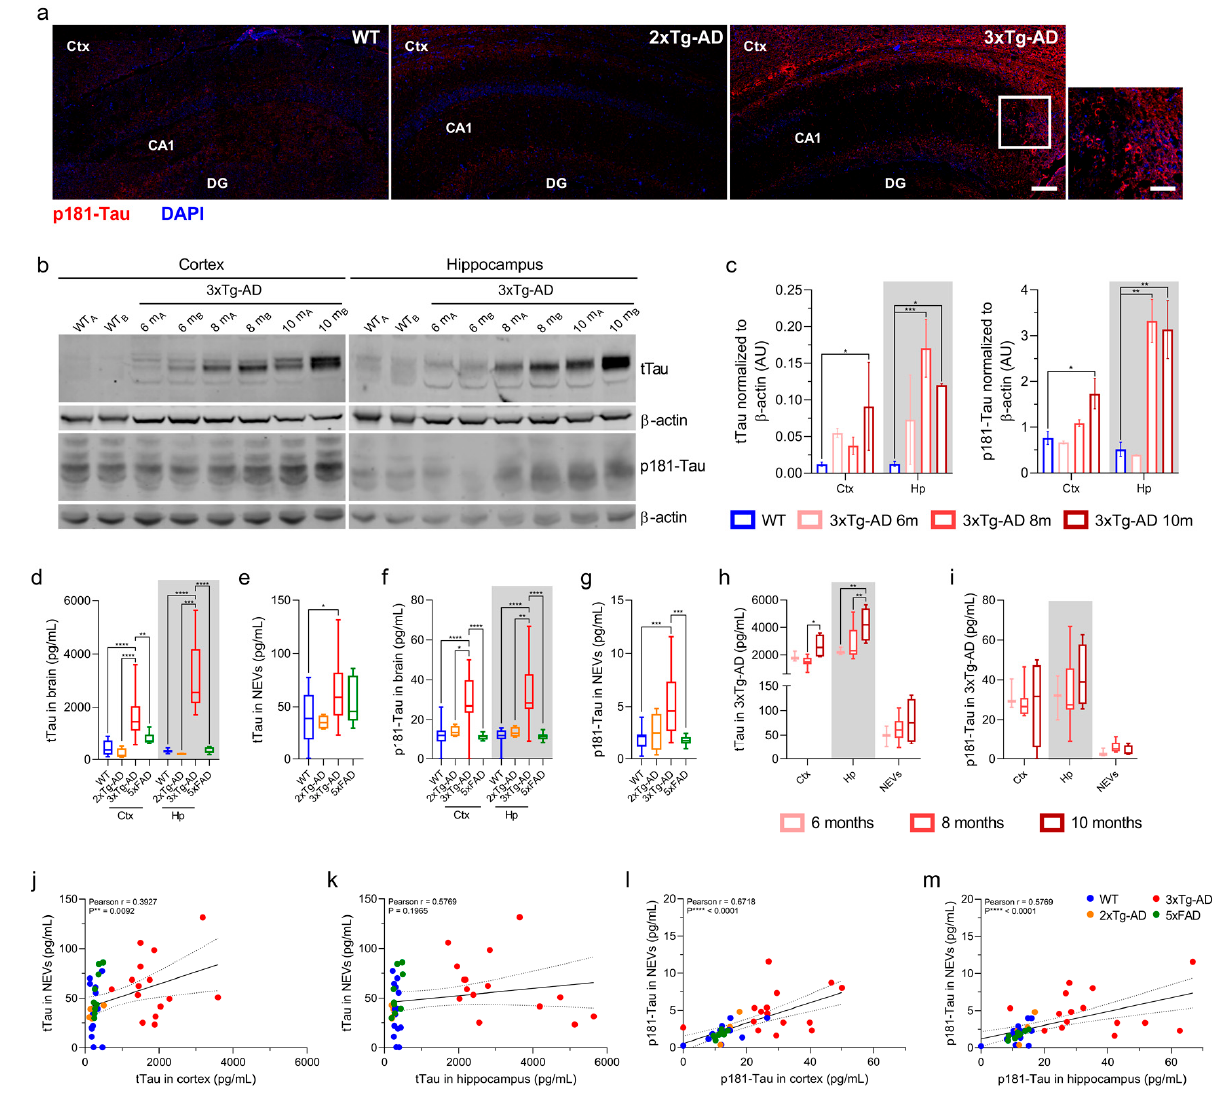
Figure 2. tTau and p181 ‐ Tau in NEVs are positively correlated with brain levels. ( a ) p181 ‐ Tau fluorescence immunohisto ‐ chemistry (red), with DAPI ‐ stained nuclei (blue), of the Ctx and Hp of a 10.5 ‐ month ‐ old 3xTg ‐ AD mouse compared to WT (5.7 months) and 2xTg ‐ AD (8.3 months) negative controls (20 X , scale bar, 200 μ m). Square inset in 3xTg ‐ AD image: scale bar, 100 μ m. ( b ) tTau (HT7) and p181 ‐ Tau (AT270) WB, resolved in individual membranes, showing brain levels of two 3xTg ‐ AD mice per age group compared to WT (6 ‐ month ‐ old). ( c ) WB quantification of tTau and p181 ‐ Tau normalized to β‐ actin (one ‐ way ANOVA; tTau in Ctx: * p = 0.0103, 10 months; tTau in Hp: *** p = 0.0002, 8 months, and * p = 0.0381, 10 months; p181 ‐ Tau in Ctx: * p = 0.0214, 10 months; p181 ‐ Tau in Hp: ** p = 0.0077, 8 months, and ** p = 0.0099, 10 months). Mice used for tTau assessment: WT, n = 6, age mean = 5.3 months; 3xTg ‐ AD, two of which are 6 ‐ months, six of which are 8 ‐ months and two of which are 10 ‐ months old (as indicated by age ‐ specific colored dots). Mice used for the p181 ‐ Tau assessment: n = 2 for all groups. ( d – g ) Box ‐ plots displaying human tTau ( d , e ) and p181 ‐ Tau ( f , g ) levels in brains and NEVs as measured by a Luminex ‐ multiarray (one ‐ way ANOVA; tTau in Ctx: **** p < 0.0001 vs. WT and 2xTg ‐ AD, *** p = 0.0019 vs. 5xFAD; tTau in Hp: **** p < 0.0001 vs. WT, 2xTg ‐ AD and 5xFAD; tTau in NEVs: * p = 0.0342 vs. WT; p181 ‐ Tau in Ctx: **** p < 0.0001 vs. WT and 5xFAD, * p = 0.0102 vs. 2xTg ‐ AD; p181 ‐ Tau in Hp: **** p < 0.0001 vs. WT and 5xFAD, ** p = 0.0021 vs. 2xTg ‐ AD; p181 ‐ Tau in NEVs: *** p = 0.0004 vs. WT and *** p = 0.0009 vs. 5xFAD). No outliers were identified. ( h , i ) tTau ( h ) and p181 ‐ Tau ( i ) Luminex ‐ multiarray results in 3xTg ‐ AD mice organized by age groups (one ‐ way ANOVA; tTau in Ctx: * p = 0.0313 for 8 vs. 10 months; tTau in Hp: ** p = 0.0028 for 6 vs. 10 months and * p = 0.0082 for 8 vs. 10 months). ( j – m ) tTau ( j , k ) and p181 ‐ Tau ( l , m ) levels in NEVs in relation to Ctx and Hp. Pearson correlation coefficient shown for each graph. 3.3. A β 42 Levels in NEVs from 5xFAD Mice Are Elevated and Correlated with Brain Levels Luminex Multiplex results in Figure 3a,b show that 5xFAD mice (~12 ‐ month ‐ old) had higher A β 42 levels in the Ctx, Hp and NEVs compared to 2xTg ‐ AD (~8 month ‐ old), 3xTg ‐ AD (~9 month ‐ old), and WT mice (~9 month ‐ old) (one ‐ way ANOVA; 5xFAD Ctx: p = 0.004